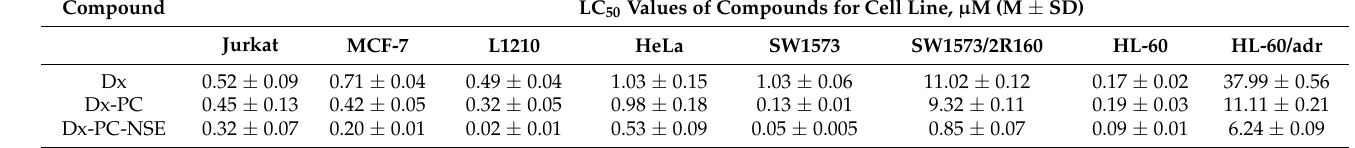
Table 2. LC 50 values of Dx, Dx-PC, and Dx-PC-NSE towards mammalian tumor cell lines in vitro. 24 h incubation, trypan blue